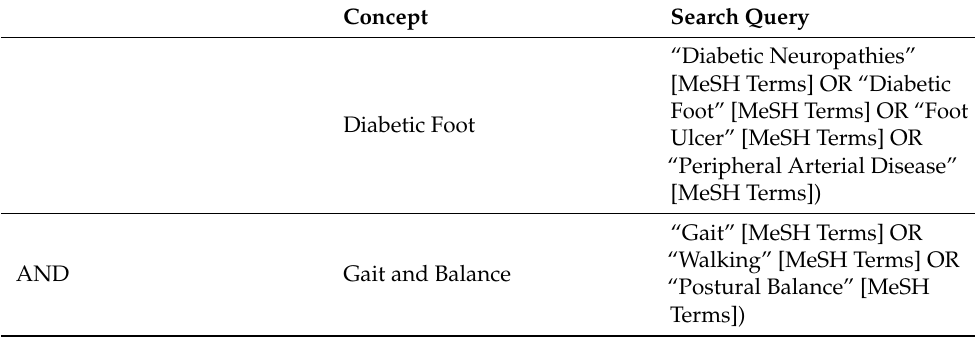
Table 1. PubMed search